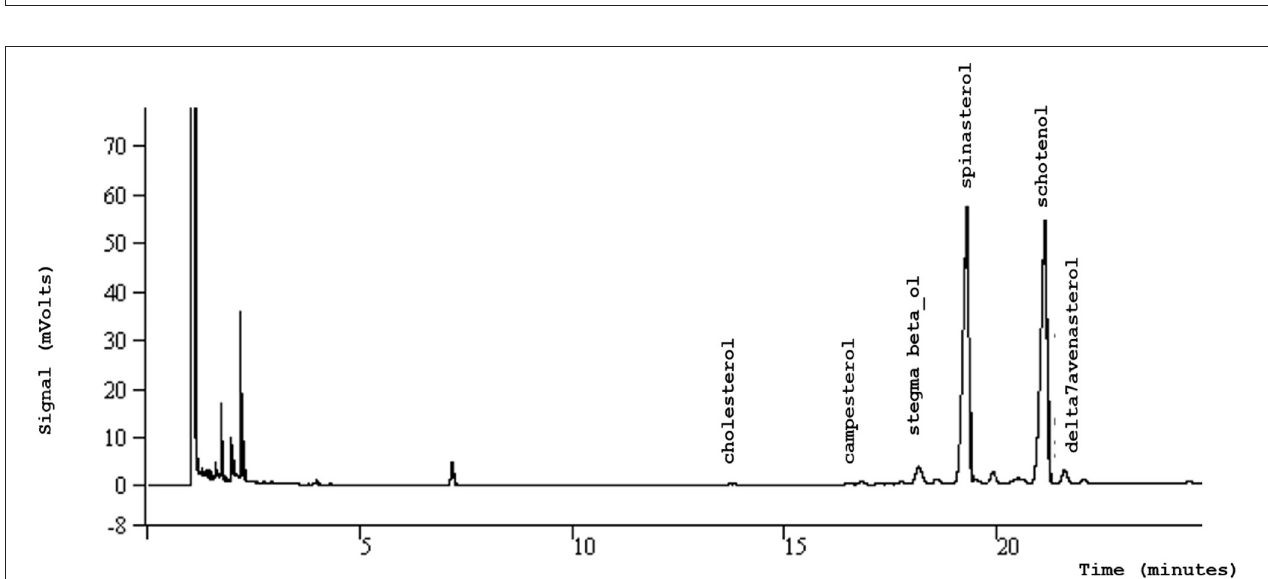
FIGURE 3 | GC chromatogram of sterols of argan